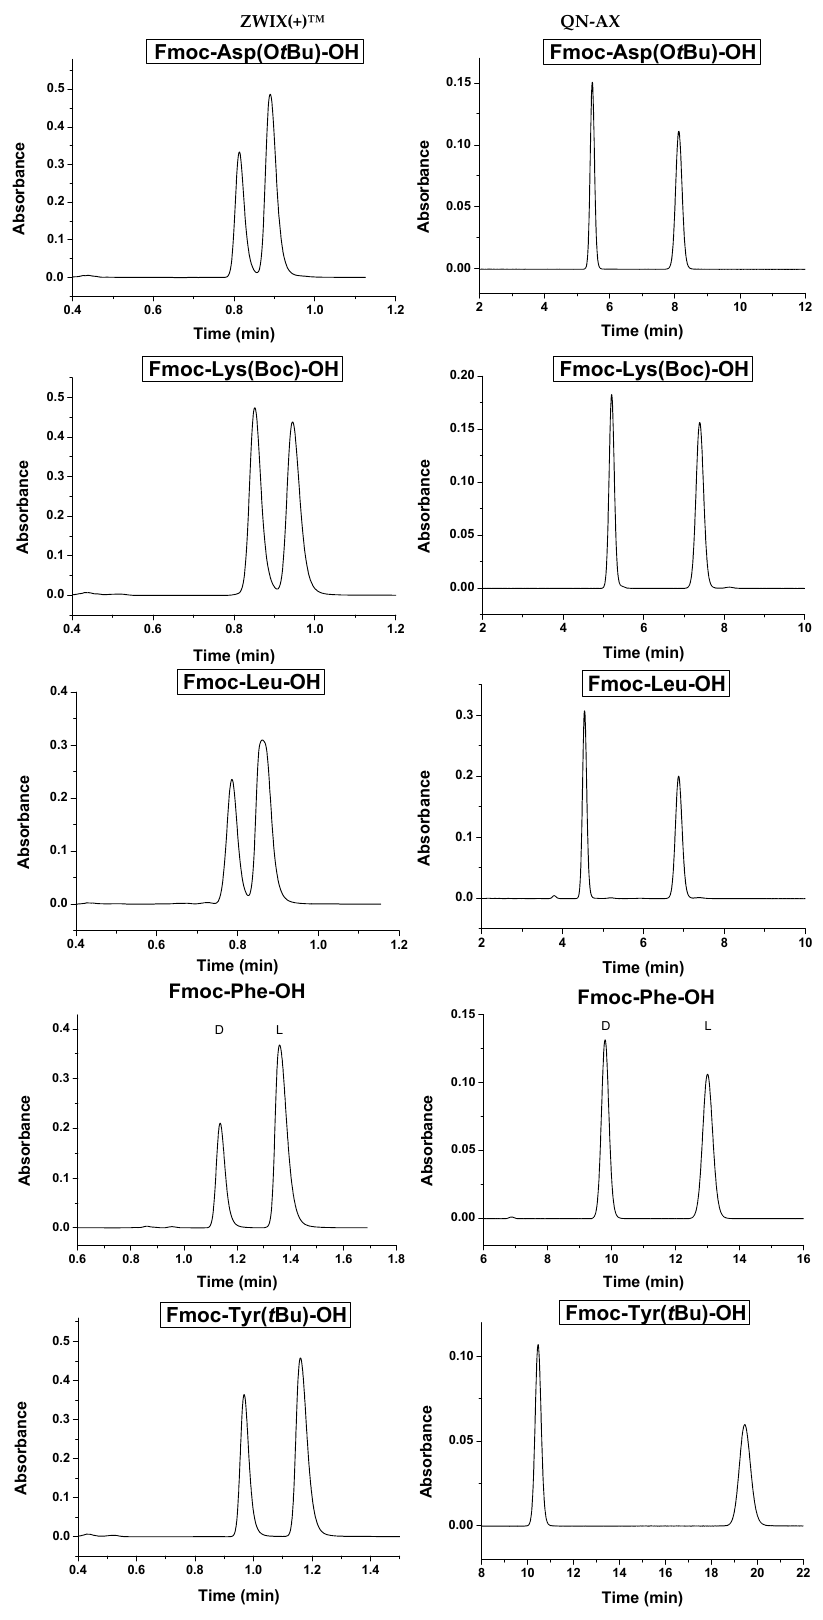
Figure 9. Selected chromatograms of N α -Fmoc-protected proteinogenic amino acids. Chromatographic conditions: columns, ZWIX(+)™ and QN-AX™; mobile phase, CO 2 /MeOH (60/40 v/v ) containing 30 mM TEA and 60 mM FA; flow rate, 2.0 mL min − 1 ; T col , 40 ° C; back pressure, 150 bar; detection, 262 nm.